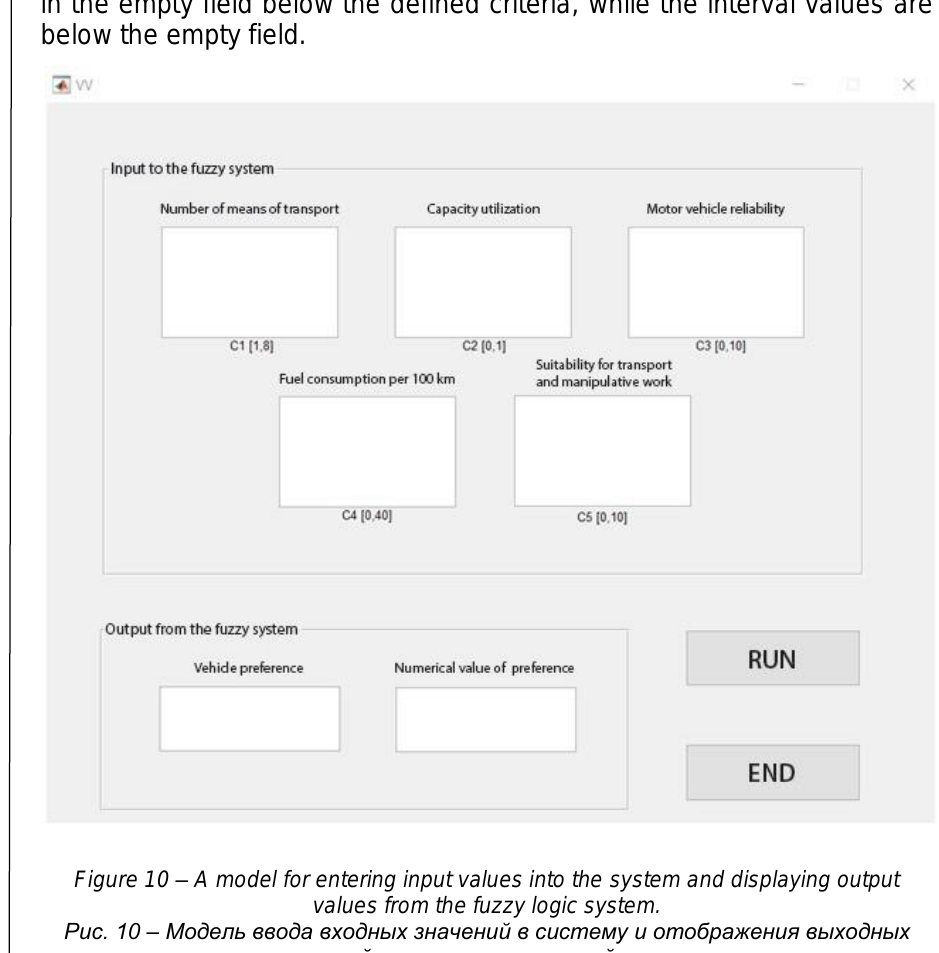
Figure 10 – A model for entering input values into the system and displaying output values from the fuzzy logic